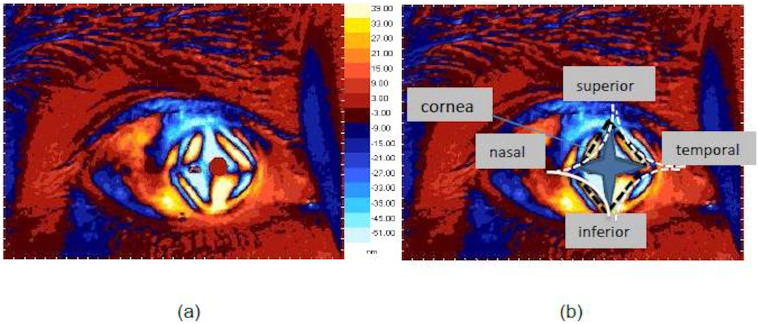
(a) Distribution of shear stress τ1 (in the unit of retardation4) and (b) same picture as in (a), but with trend lines of the direction of collagen fibrils16 superimposed. Fibrils are the basic structural elements of human eye. In general, about 60% of fibrils are oriented along the 45° orthogonal directions (shown as diamond-like structure16 in dotted lines) and the remaining fibrils are oriented in between these orthogonal sectors and assist in maintaining the corneal shape15.